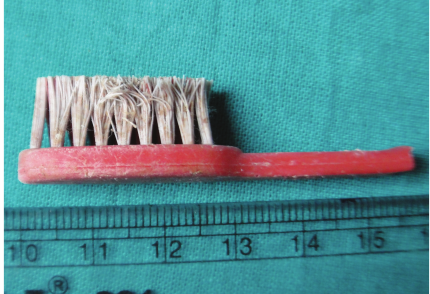
Figure 6: The toothbrush (5.8cm × 1.5cm) with sharp broken edge after